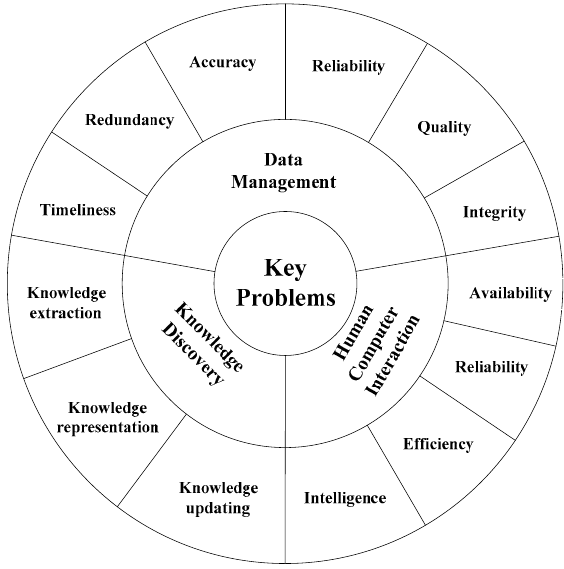
Figure 6. The key issues facing the MC–SIOT system.